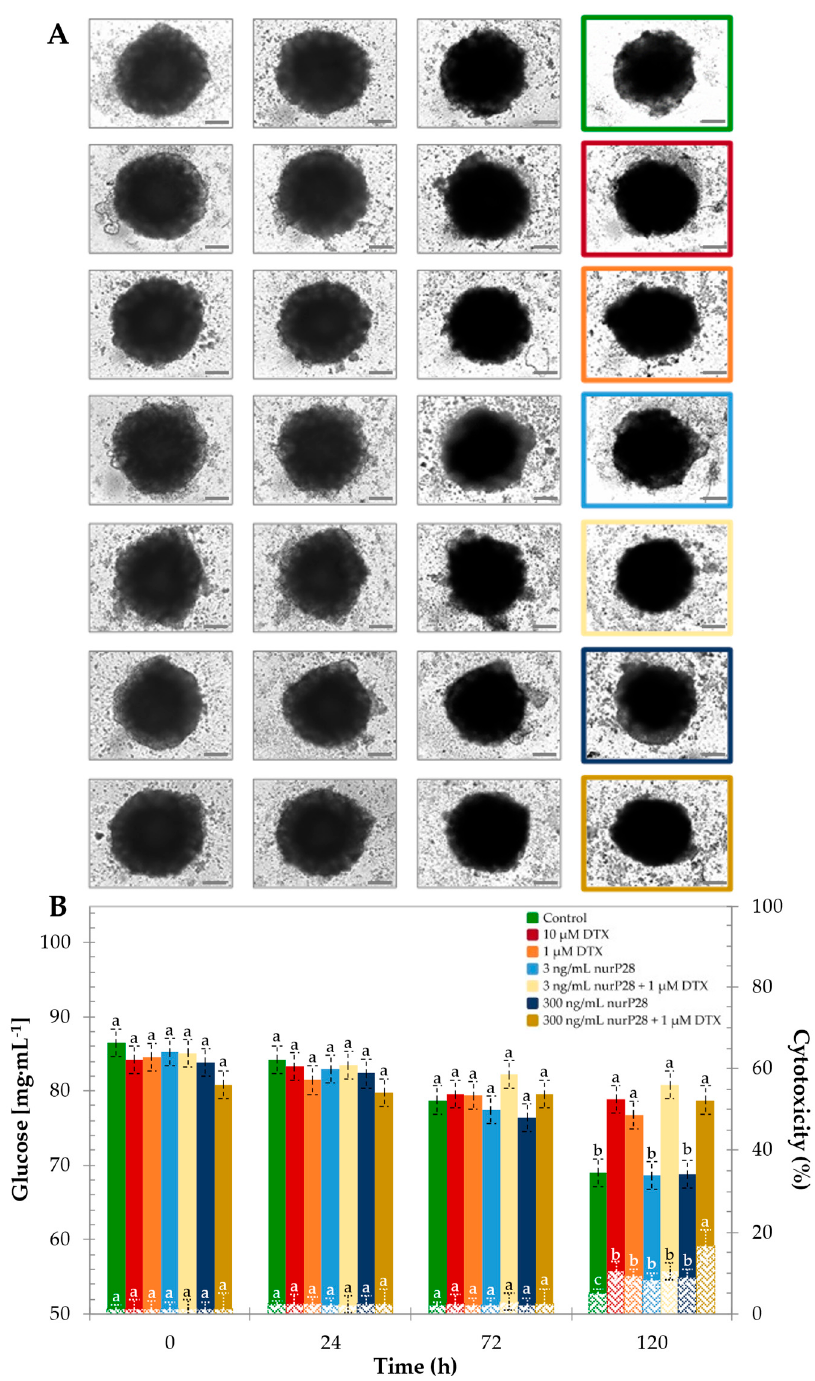
Figure 6. Monitoring breast cancer MCF7 spheroids treated with nurP28 peptide alone and in combination with DTX at 0, 24, 72, and 120 h. ( A ) Bright-field images of MCF7 spheroids exposed to the different treatments; ( B ) Glucose concentration (primary axis), and cytotoxicity (secondary axis), assayed by LDH, from culture media of the treated spheroids. Results expressed as mean ± SD ( n = 3). The letters a, b and c indicate a statistically significant difference at p < 0.01. Bars with no common letters are significantly